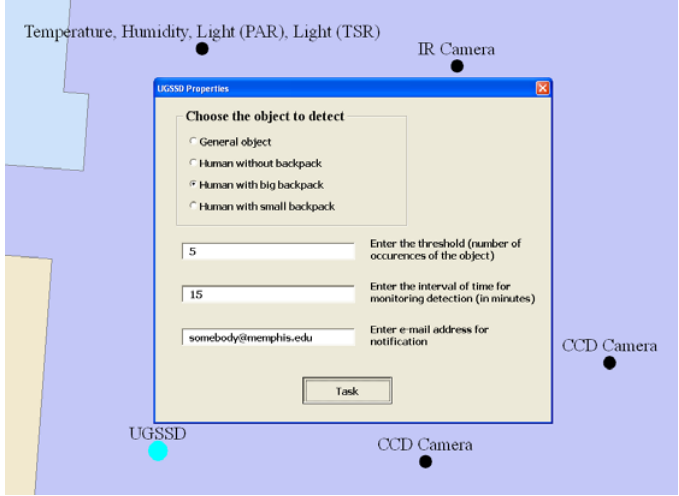
Figure 8. GIS interface for setting UGSSD tasking parameters. The interface requires four inputs to be specified by the user: (i) the type of object to detect; (ii) the threshold indicating the number of occurrences of the object to detect before a notification is